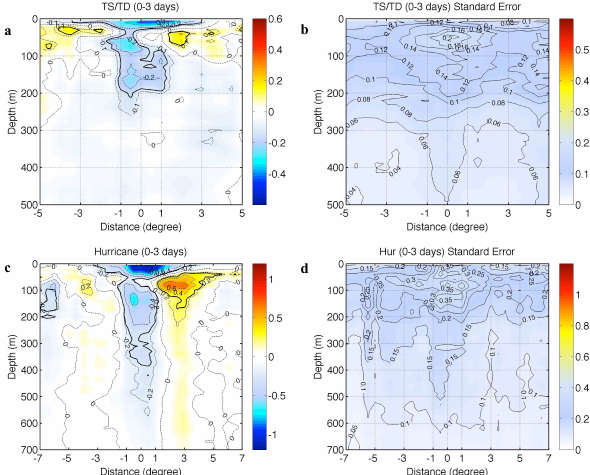
Figure 2. The 0–3-day averaged thermal changes (relative to pre- storm conditions) as a function of depth and distance, in TC track coordinates. (a) TS/TD, between + 5 and − 5 ◦ from the track center; the dashed contour interval is 0.1 ◦ C, and the solid black contours isolate the 90% confidence interval of the signals. The standard er- ror of the footprint is presented in (b) . (c) is the 0–3-day footprint for hurricanes, between ± 7 ◦ from the track center, the dashed con- tour interval is 0.2 ◦ C, and the solid black contours isolate the 90% confidence interval of the signals. The standard error of the footprint is presented in (d) . The unit is ◦ C.